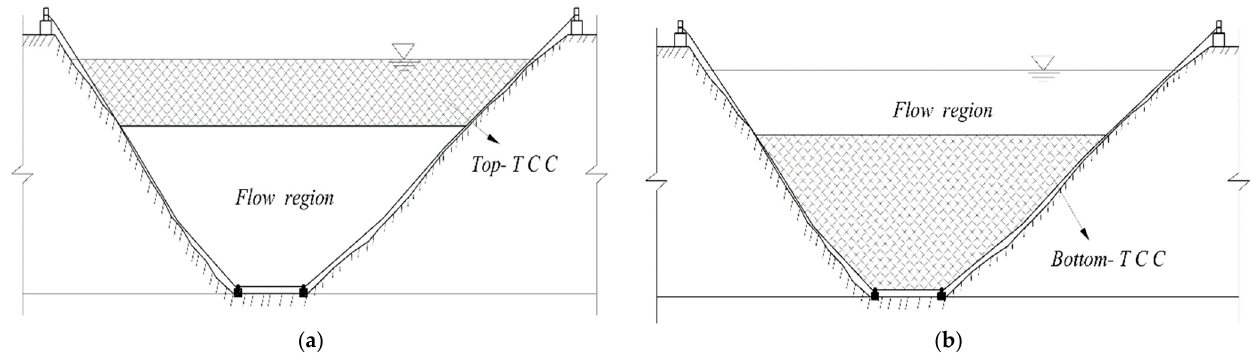
Figure 1. Schematics about different types of TCC: ( a ) Top-TCC; ( b ) Bottom-TCC.